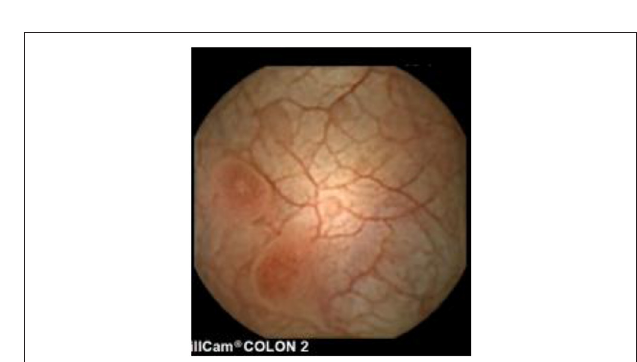
FIGURE 4 | Severe Crohn’s with ulceration and stenosis.